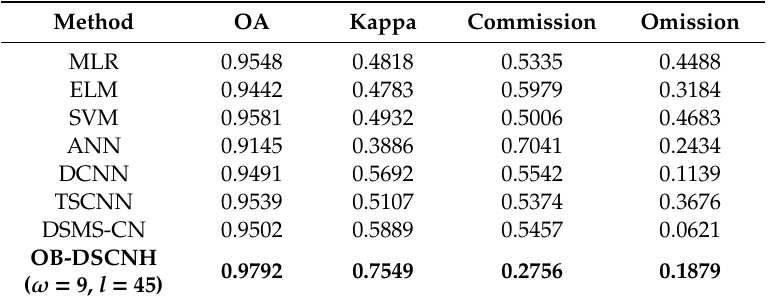
Table 4. Accuracy of the di ff erent change detection methods on the third